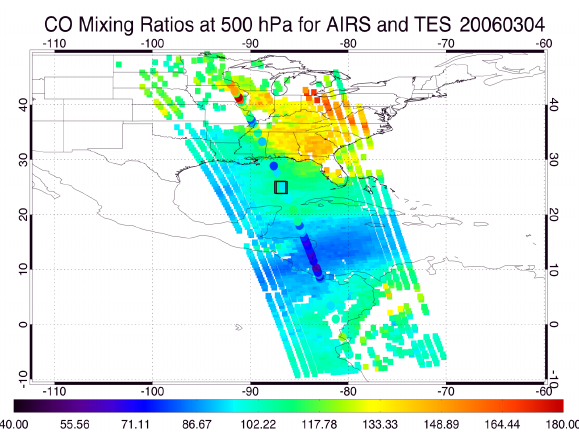
Fig. 4. The footprints of AIRS and TES special observations for 4 March 2006, where the squares represent AIRS CO mixing ratios (ppbv) at 500hPa, the filled circles represent those for TES, and the black box outlines the location of the DC-8 in situ spiral profile.